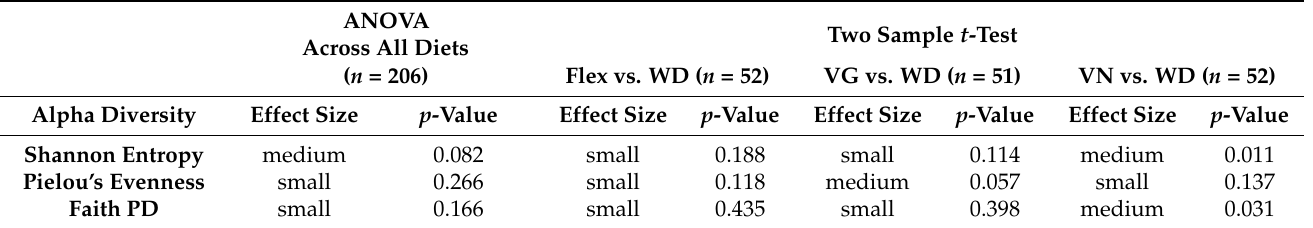
Table 1. Difference of alpha diversity across all diet types (WD, Flex, VG, VN) and between diet types (Flex, VG, VN) compared to the reference diet